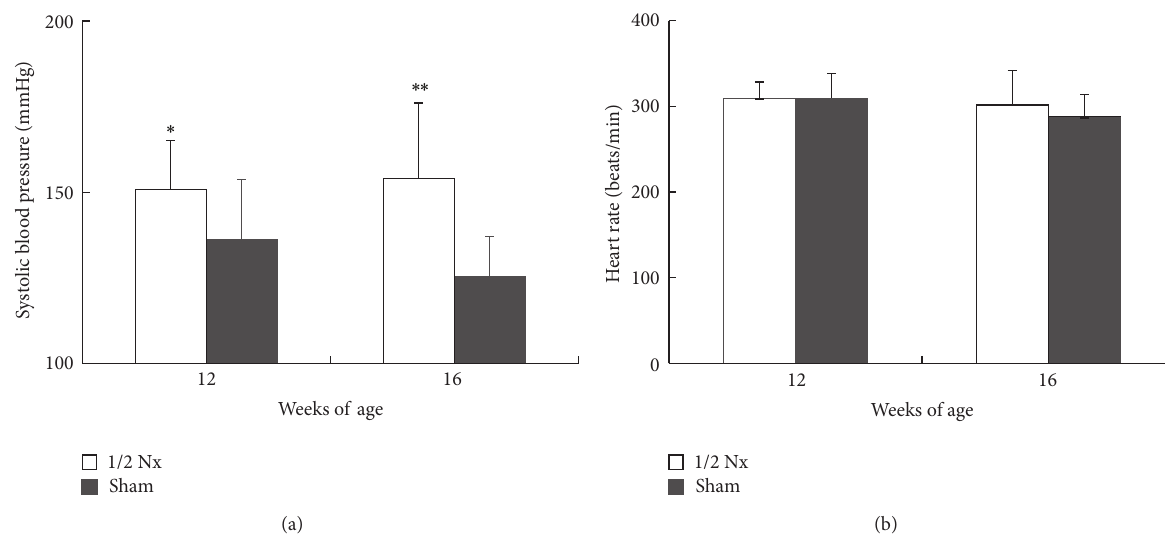
Figure 2: Systolic blood pressure (a) and heart rate (b) at 12 and 16 weeks of age in the 1/2 Nx group and sham group. Data shown as means ± SD ( 𝑛 = 8 –10). ∗ 𝑃 < 0.05 , ∗∗ 𝑃 < 0.01 ; significantly different from the sham group.